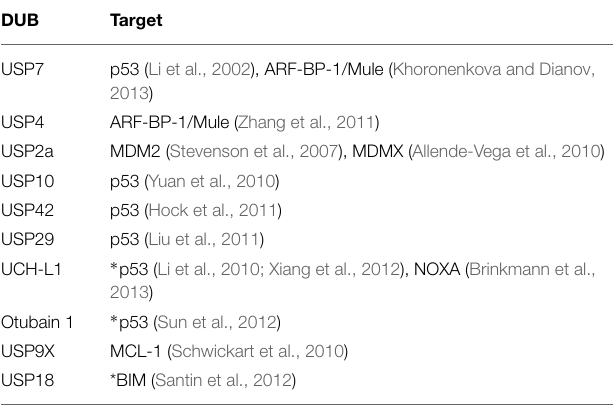
TABLE 2 | DUBs involved in